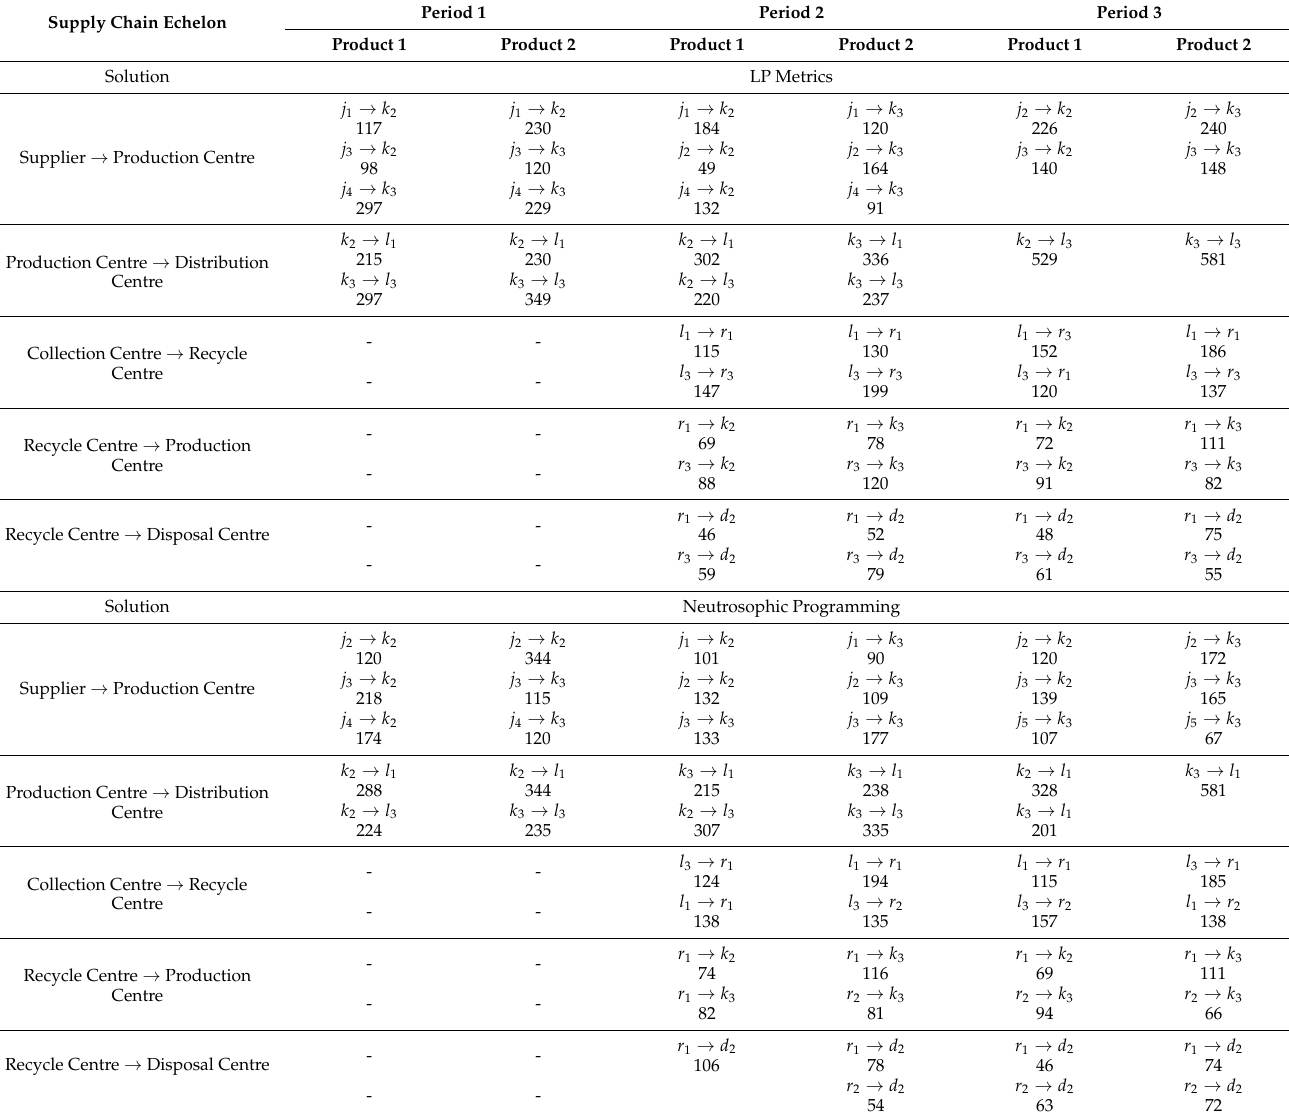
Table 8. Optimal allocation of medical equipment transmission flow between supply chain network